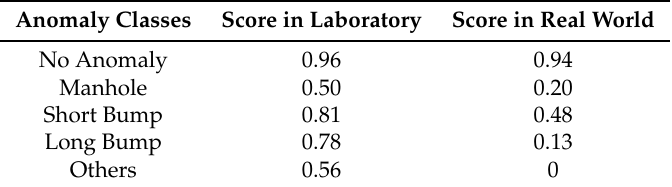
Table 2. Score per class.